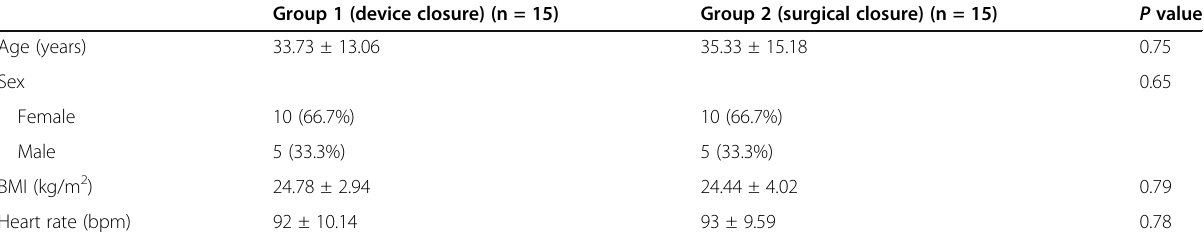
Table 1 Demographic date of studied patients Group 1 (device closure) (n = 15)